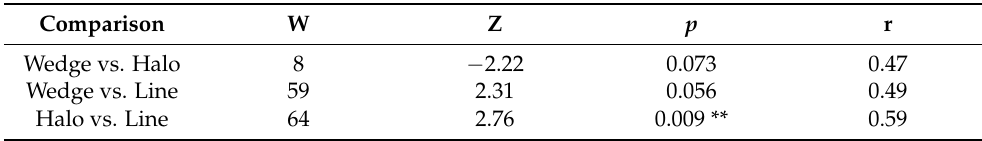
Table 2. Pairwise comparisons of reaction times for the visualization techniques: Wedge ; Halo ; and Line